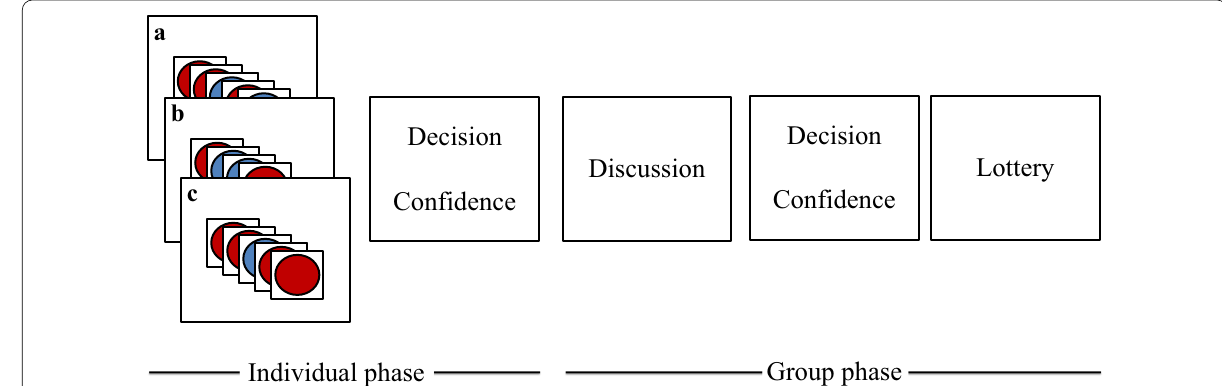
Fig. 1 Individual and group phase in each trial. In the individual phase, each participant viewed different stimulus sequences consisting of 11–13 disks. Based on these sequences, individuals decided whether their sequence has more likely been produced by a fair coin (50% red, 50% blue) or a biased coin (60% red, 40% blue). Based on the ambiguity of the sequence, individuals reported a confidence in their own decision. In the group phase, participants combined their evidence into one group decision and confidence. In each trial, participants were incentivized for accurately judging their real group confidence using the matching probability method by Massoni et al.